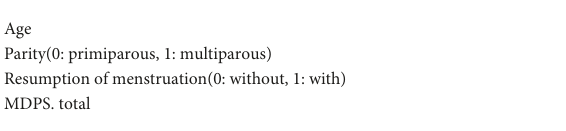
TABLE 4 Final version of the MDPS-M and score calculation